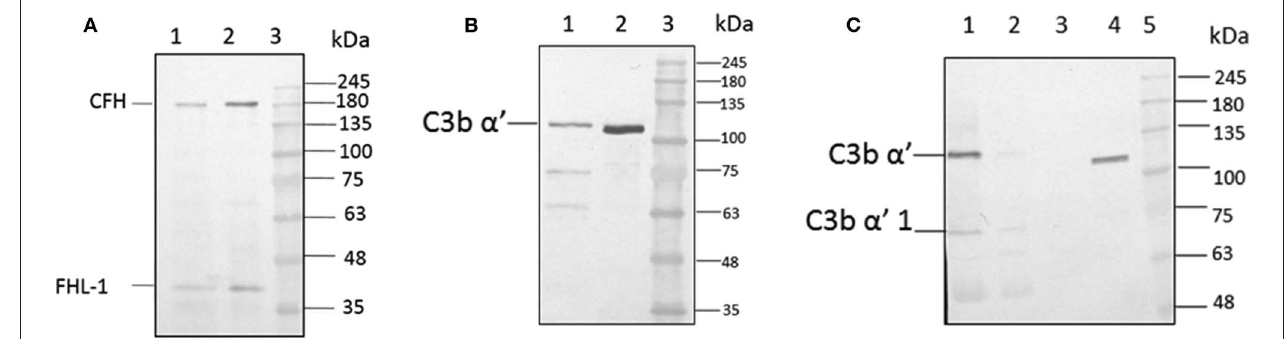
FIGURE 2 | C3b and CFH binds to conidial surface. (A) A. flavus conidia were incubated with 2.0 µ g factor H, washed and eluted the surace bound proteins, which were separated by SDS-PAGE, transferred to a NC membrane and probed with anti-CFH antibody. Lanes 1, Eluate of 2.0 µ g of CFH bound to the spore; 2, 200 ng of pure protein CFH; 3, protein marker (PM). (B) A. flavus conidia (2 × 10 8 ) were incubated with purified C3b (5 µ g). After extensive washing, bound proteins were eluted with 1X Laemmli buffer. Proteins in eluate were separated in a SDS-PAGE, transferred to a NC membrane and probed with anti-C3b antibody. Lanes 1, Eluate of 5 µ g of C3b bound to the spore; 2, 500 ng of pure protein C3b; 3, protein marker (PM). (C) Binding of C3b in keratitis patient tear to conidial surface. A. flavus conidia were incubated with purified 50 µ g of A. flavus keratitis patient tear. After extensive washing, bound proteins were eluted with 1X Laemmli buffer. Proteins in the eluate were separated in a SDS-PAGE, transferred to a NC membrane and probed with anti-C3b antibody. Lanes 1, 10 µ g of keratitis patient tear; 2, unbound proteins of keratitis patient tear; 3, wash fraction; 4, eluate of patient tear proteins bound to the spore surface; 5, protein marker (PM).